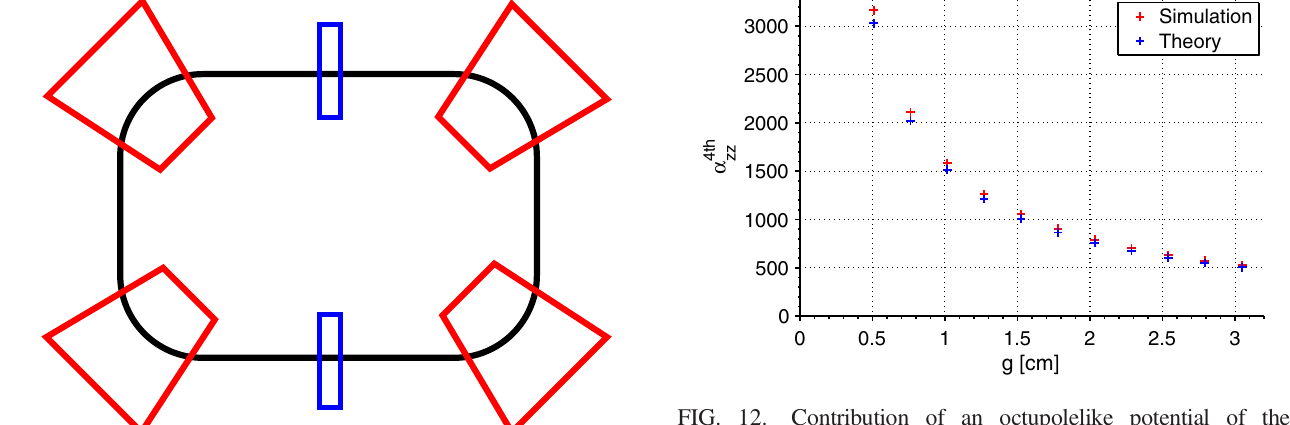
FIG. 12. Contribution of an octupolelike potential of the effective fringe field map on the detuning parameter. The super- script “ 4th ” denotes the detuning contributed by only the 4th-order potential. The tune is calculated by applying a numerical analysis of fundamental frequencies [20] algorithm on numerical turn-by- turn tracking data. When we track the particles, we gave a fringe field kick according to Eqs. (40) – (47) which are verified by Figs. 3 – 7 and Ref. [1]. And the detuning is calculated from the difference of the tunes for different initial amplitudes of the betatron motion on tracking data.